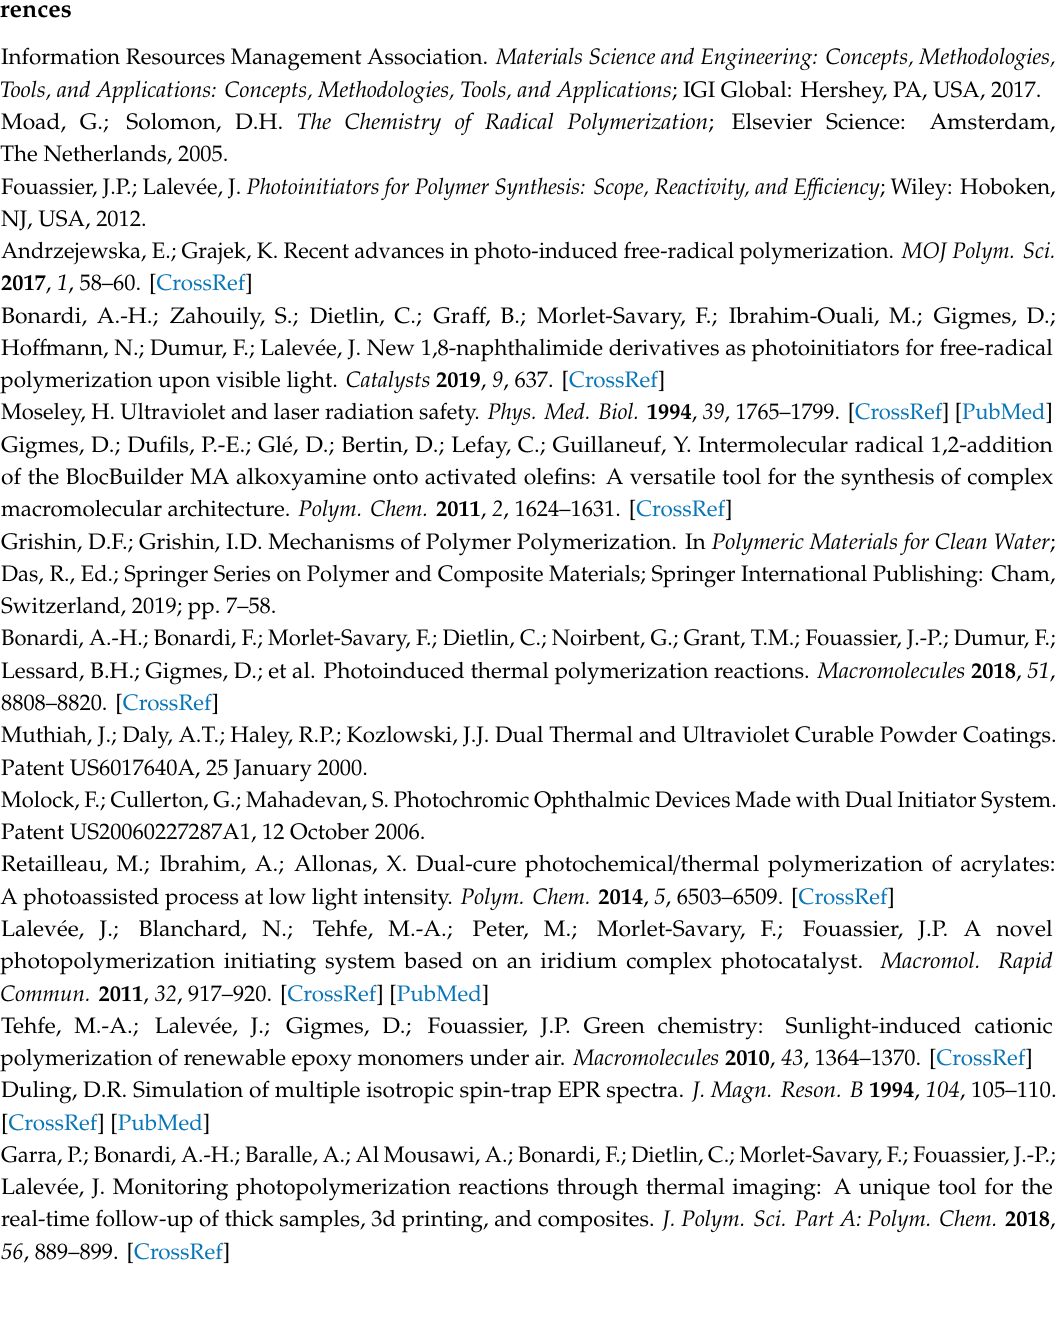
Figure S1: Temperature profiles of Mix-MA under air (temperature of the sample vs. irradiation time) in the presence of (1) monomer alone (2 wt.%), (2) Napht (0.1 wt.%), (3) Ar 2 I + / PF 6 − (1.5 wt.%), (4) BlocBuilder-MA (2 wt.%), (5) 4-dppba (0.5 wt.%); LED@405 nm (110 mW cm − 2 ); thickness = 10 mm; under